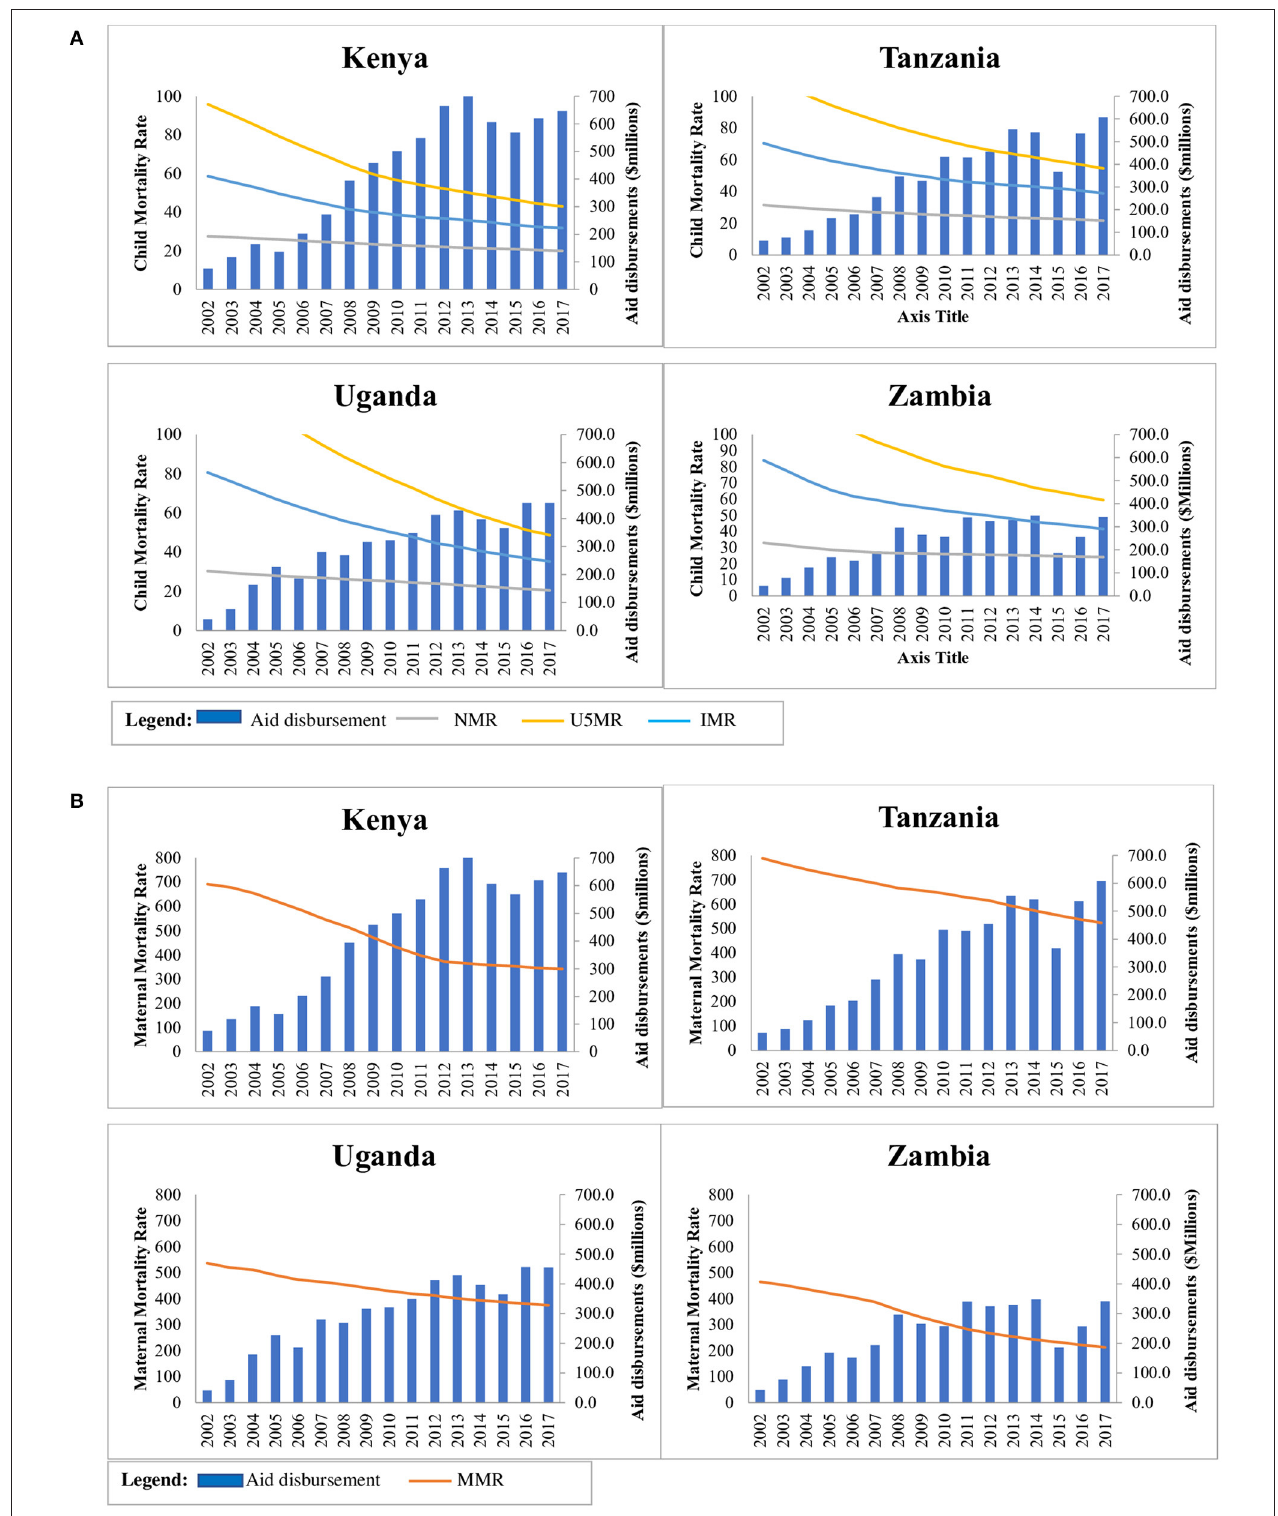
FIGURE 4 | (A) Comparison of aid disbursements with neonatal, under five and child mortality rates. (B) Comparison of aid disbursements with maternal mortality rates.